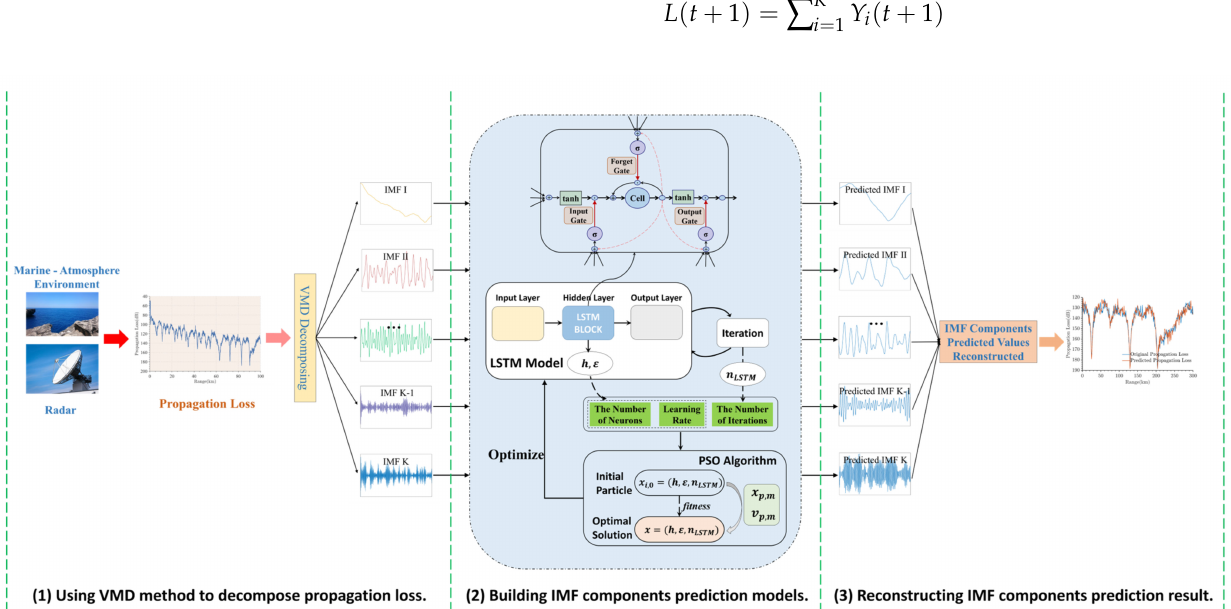
Figure 6. General framework of the VMD − PSO − LSTM